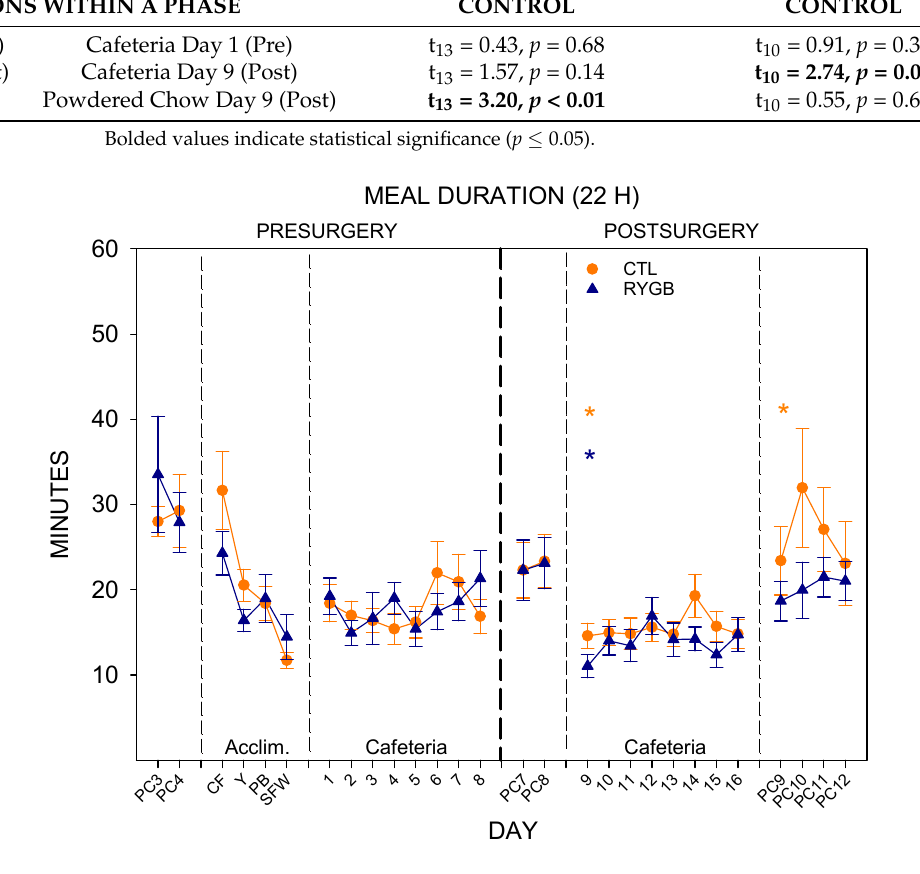
Figure 8. Meal Duration across All 22-H Periods during Meal Pattern Monitoring. Mean (±SE) meal size (in min) for CTL (combined SHAM and IRON groups, n = 14; orange circles) and RYGB ( n = 11; blue triangles) rats for powdered chow days (PC), acclimation days for each food (Acclim.; CF: chickpea flour; Y: yogurt; PB: peanut butter; SFW: sugar/fat whip), and cafeteria diet days. Dashed vertical lines indicate transitions between diet conditions (thin dashed) and between pre- and post-surgical phases (thick dashed). Statistically significant results from two-way mixed ANOVAs (Table 8) are indicated by horizontal lines: Gray solid (group), dark gray solid (day), or gray dashed (group × day interaction). *: Statistically significant result of a paired t -test (Table 9) for the group indicated by color, comparing the marked day to the previous day. Table 8. Two-way ANOVAs Comparing 22-H Meal Duration between Groups for Each Diet Condition.